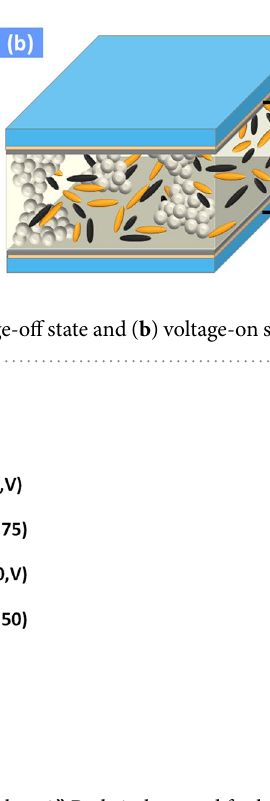
Figure 4. Voltage-dependent lens power of “LC lens 1” and “LC lens 2”. Red circles stand for lens power of “LC lens 1” at a fixed V 1 of 70 V rms while at different V 2 ( f = 7 kHz), and blue hollow diamonds stand for lens power of “LC lens 1” at different V 1 while at a fixed V 2 of 75 V rms ( f = 2 kHz). Red dots stand for lens power of “LC lens 2” at a fixed V 1 of 90 V rms while at different V 2 ( f = 3.75 kHz), and blue diamonds stand for lens power of “LC lens 2” at different V 1 while at a fixed V 2 of 50 V rms ( f = 0.4 kHz). The apertures of “LC lens 1” and “LC lens 2” are 4 mm and 10 mm,